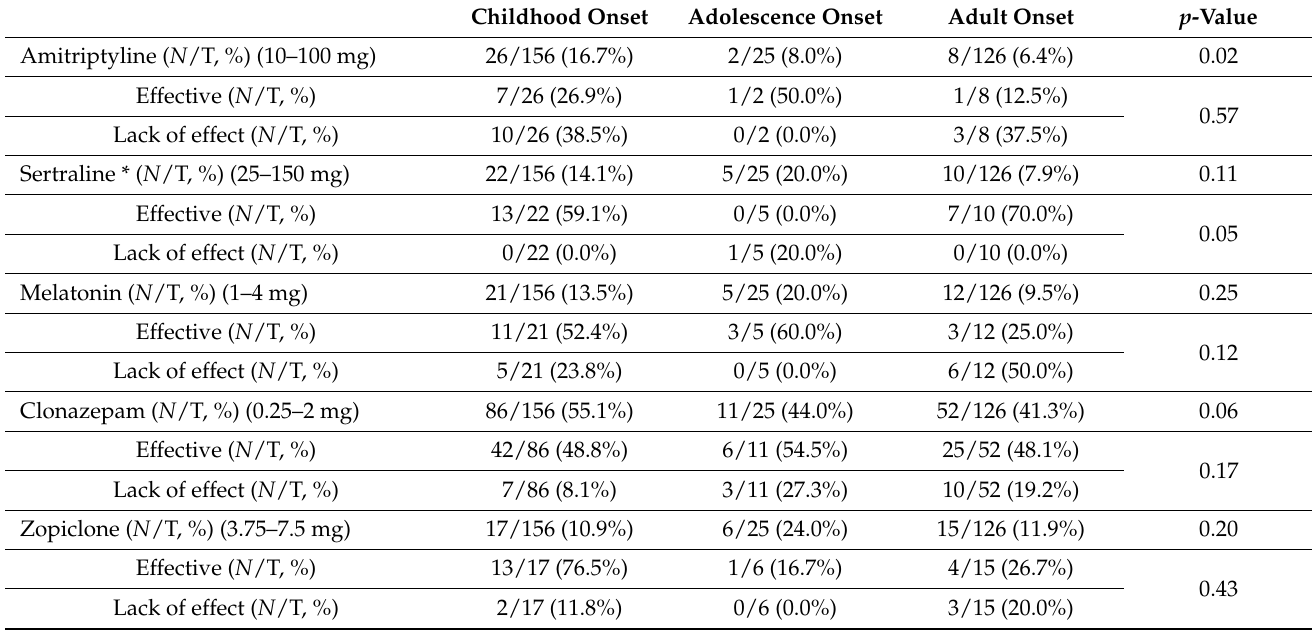
Table 8. Efficacy of de novo pharmaceutical treatment in patients with NREM parasomnia split by age of onset ( p at 0.05/3 =